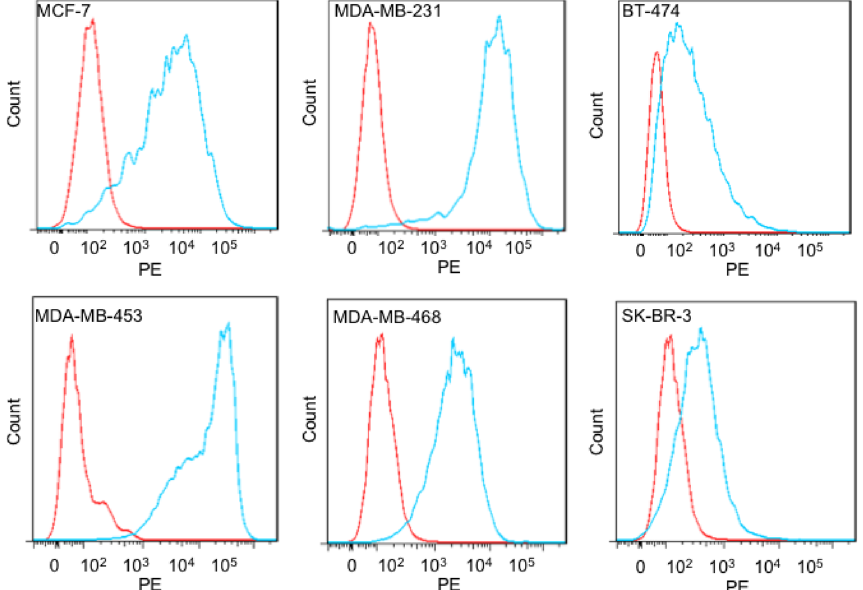
Figure 1. Flow cytometric analysis of TrkB expression in breast cancer cell lines. Flow cytometric analysis of six breast cancer cell lines using anti-TrkB mAb 641 (blue) or an isotype control mAb (red) detected by a secondary anti-human-PE antibody.